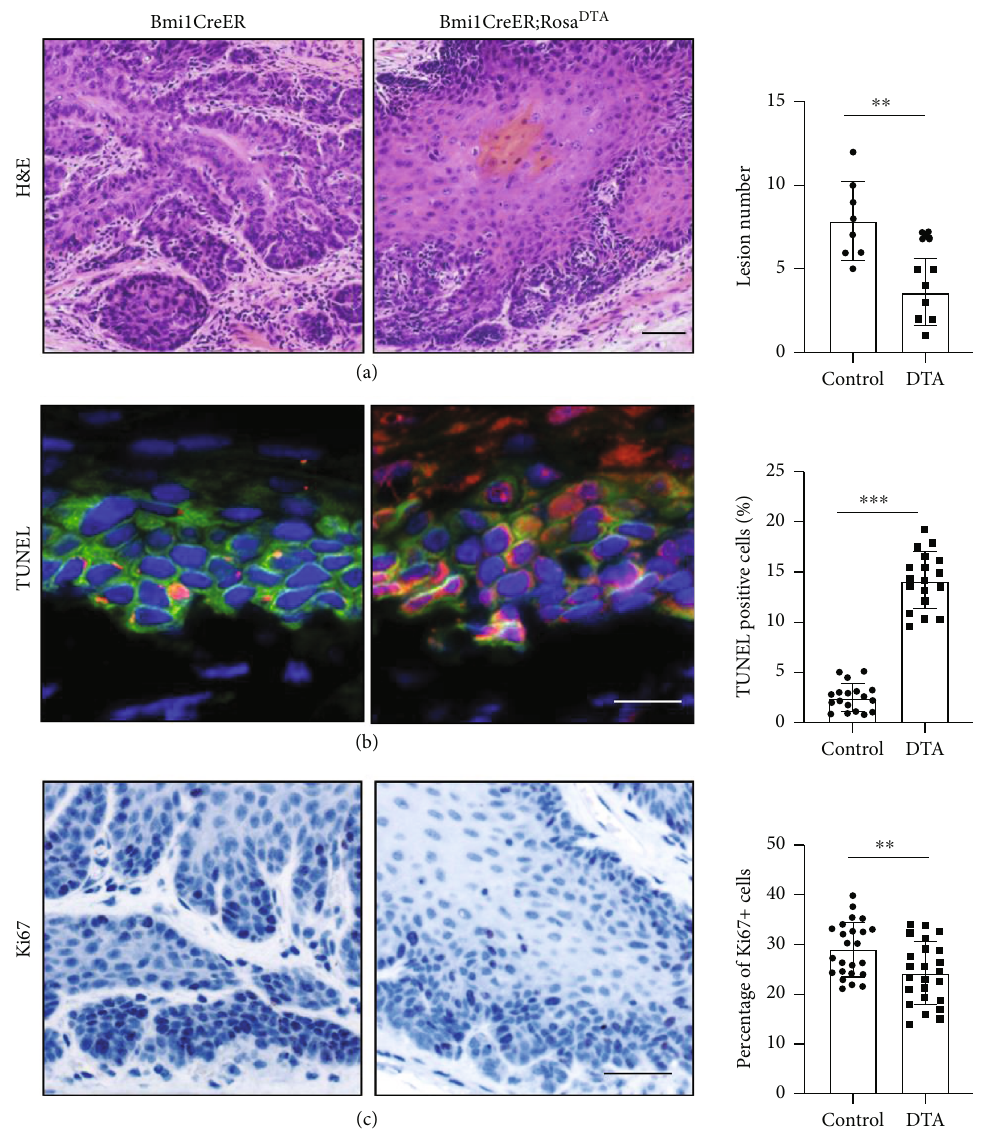
Figure 3: Depletion of Bmi1 + cells led to decreased proliferation and increased apoptotic phenotype in ESCC. (a) Bmi1CreER;Rosa tdTomato ;Rosa DTA mice were compared with the control in the malignant degree of ESCC. (b) Apoptosis of the Bmi1CreER;Rosa tdTomato ;Rosa DTA group was higher than that of the control group under the TUNEL test. Red indicates apoptotic cells. (c) Ki67 signal was reduced in ESCC without Bmi1 + cells, and Ki67 signal was represented by black. ∗ p < 0 : 05 , ∗∗ p < 0 : 01 , and ∗∗∗ p < 0 : 001 . Scale bars are 100 μ